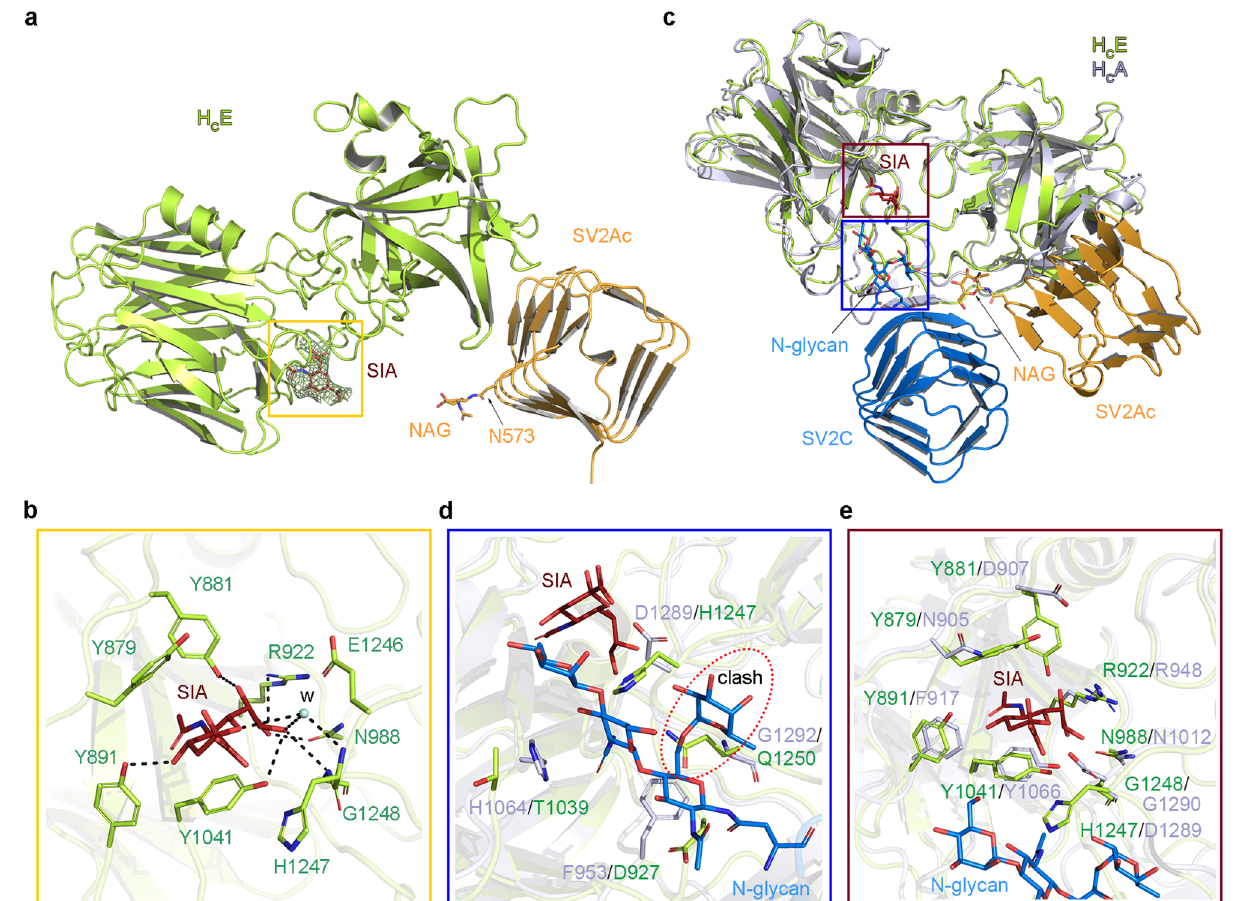
Fig. 4| Structureofthesialicacid-boundH C E – SV2Accomplex andcomparison of the glycan-binding modes between BoNT/E and BoNT/A. a Cartoon repre- sentation of the sialic acid (SIA)-bound H C E – SV2Ac complex with H C E colored in lemon, SV2Ac in orange, and sialic acid in red. An omit electron density map for sialic acid contoured at 1.5 σ wasoverlaid with the fi nal re fi ned model. b A close-up view of the interactions between H C E and sialic acid. One water molecule (W) that mediates the H C E – SIA binding is shown as a cyan sphere. c The H C E – SV2Ac – SIA complexandtheH C A – SV2Ccomplex(PDB:5JLV)weresuperimposedbasedonH C E